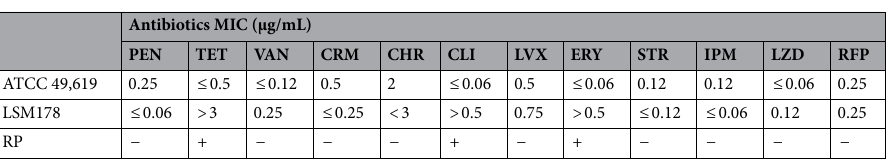
Table 1. Minimal inhibitory concentration (MIC) of 12 antimicrobial agents for LSM178 and the resistance phenotype (RP). Abbreviations PEN, penicillin; TET, tetracycline; VAN, vancomycin; CRM, cefuroxime; CHR, chloramphenicol; CLI, clindamycin; LVX, levofloxacin; ERY, erythromycin; STR, Streptomycin; IPM, Imipenem; LZD, Linezolid; RFP, rifampicin; + , resistance; − , sensitivity.